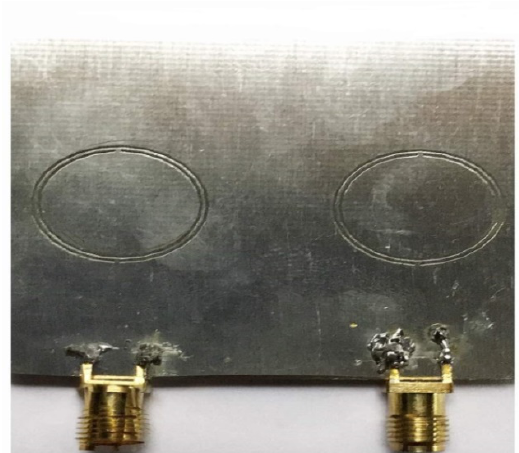
Figure 6: Fabricated antenna (a) Top layer.